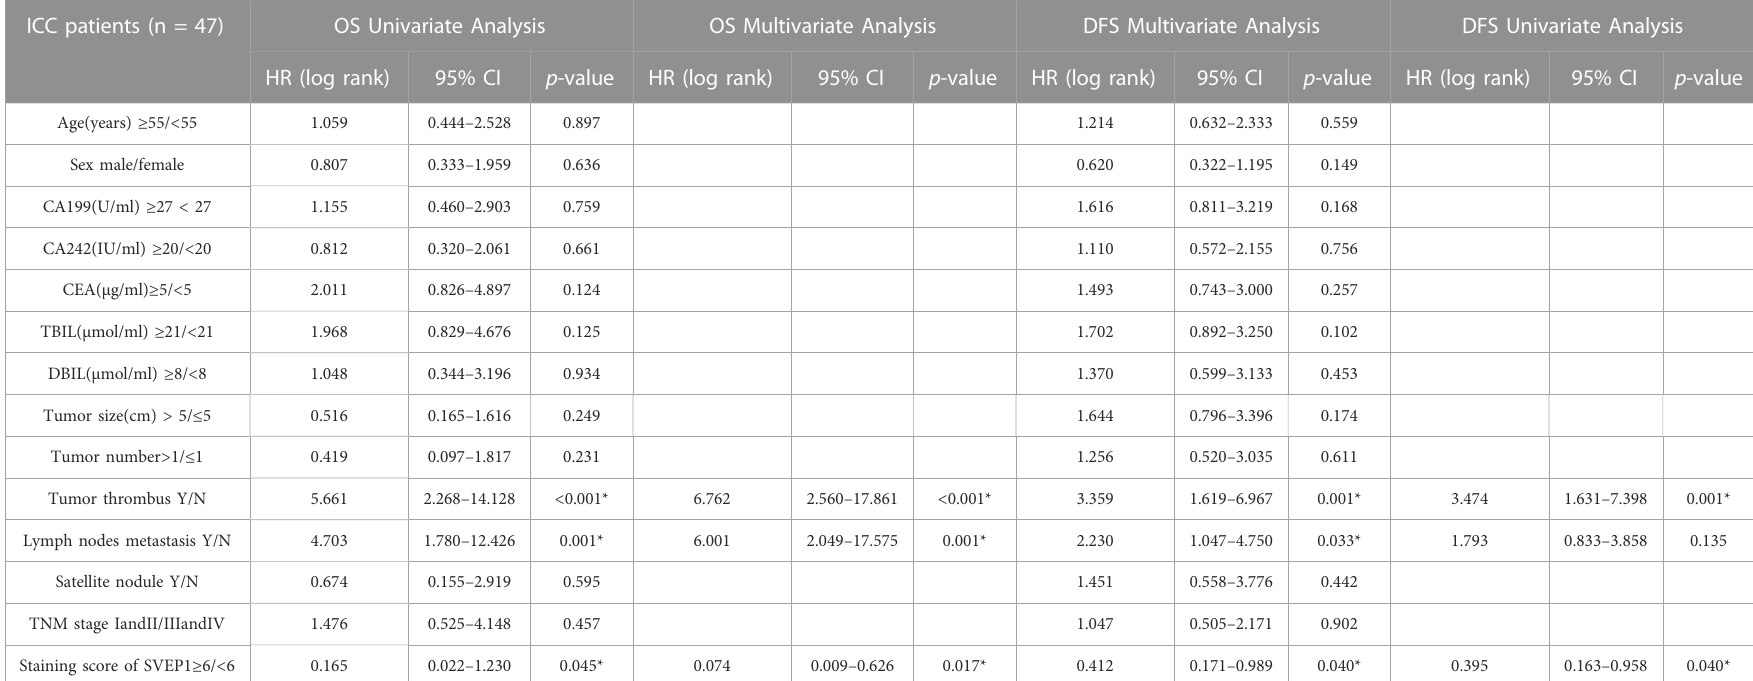
TABLE 1 Univariate and multivariate analysis of prognostic factors associated with OS and DFS in 47 ICC